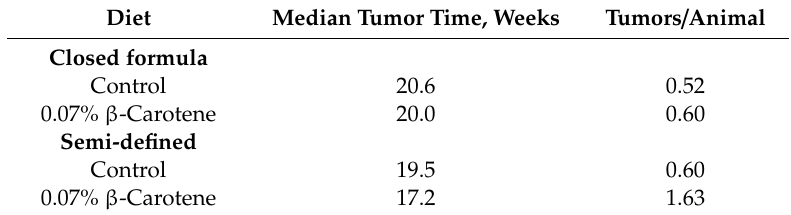
Table 1. Influence of diet on β -carotene-mediated UV-carcinogenic expression *. Diet Median Tumor Time, Weeks